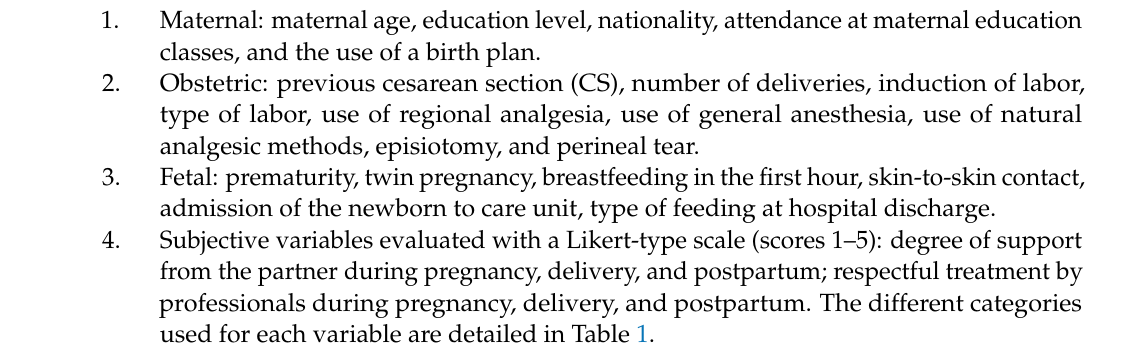
Table 1. Bivariate analysis of potential predictive factors of post-traumatic stress disorder (PTSD) risk.